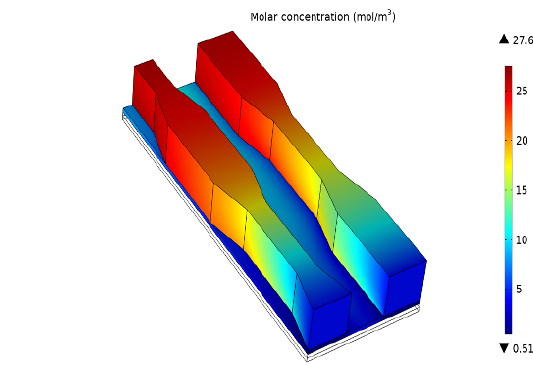
Figure 8. Hydrogen mole fraction distribution in conventional channel and novel channel .